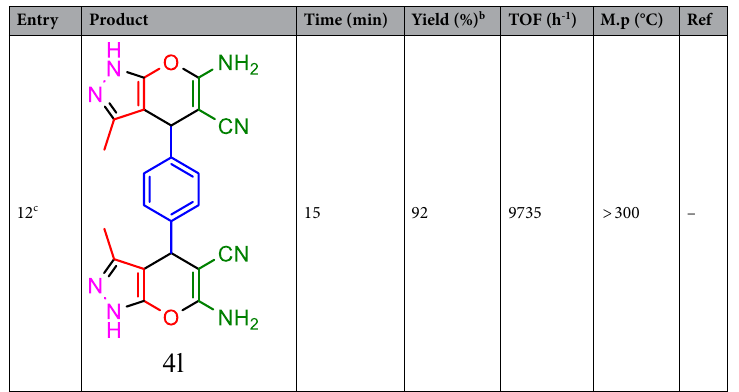
Table 10. One-pot synthesis of 1,4-dihydropyrano[2,3-c]pyrazole with aldehyde, malononitrile, ethyl acetoacetate and hydrazine hydrate catalyzed by HMS/Pr-PTSC-Cu a . a Reaction conditions: aldehyde (1 mmol), malononitrile (1 mmol), ethyl acetoacetate (1 mmol), hydrazine hydrate (1 mmol), HMS/Pr-PTSC-Cu (0.006 g) in H 2 O: EtOH (2:1 mL) at room temperature. b Pure yield. c Reaction conditions: aldehyde (1 mmol), malononitrile (2 mmol), ethyl acetoacetate (2 mmol), hydrazine hydrate (2 mmol), HMS/Pr-PTSC-Cu ( 0.012 g) in H